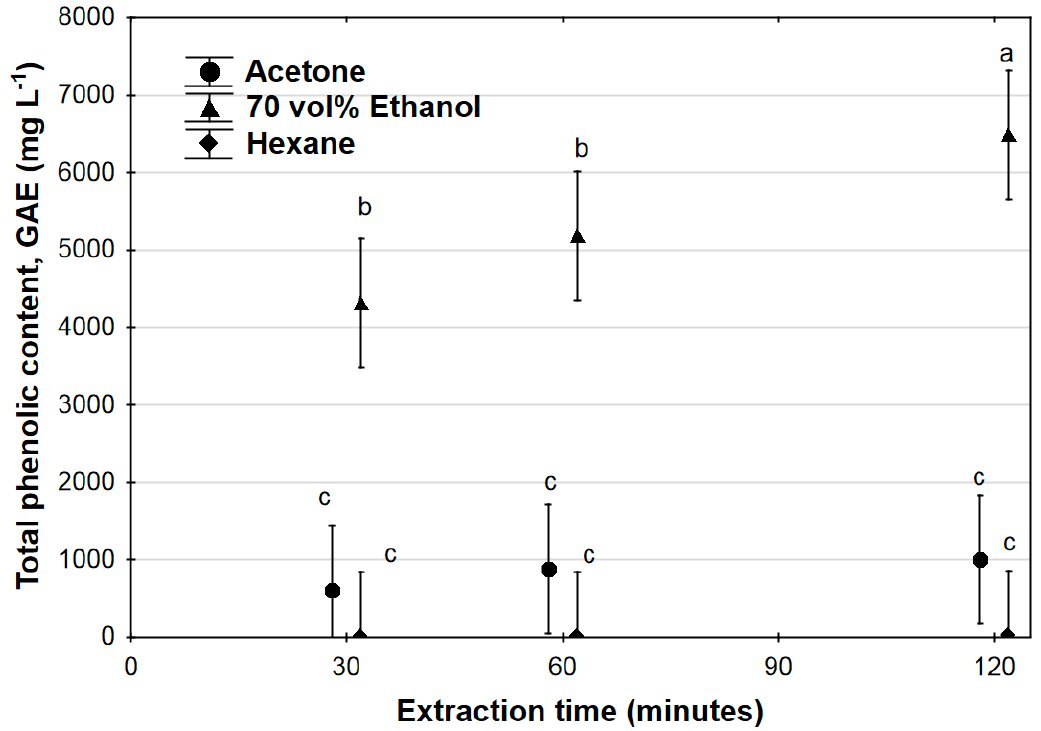
Figure 1. Total phenolic content of Ximenia caffra extracts over time, for different solvents, expressed as gallic acid equivalents (GAE). Data are represented as mean ± 95% confidence intervals. Values with common superscripts do not differ significantly.